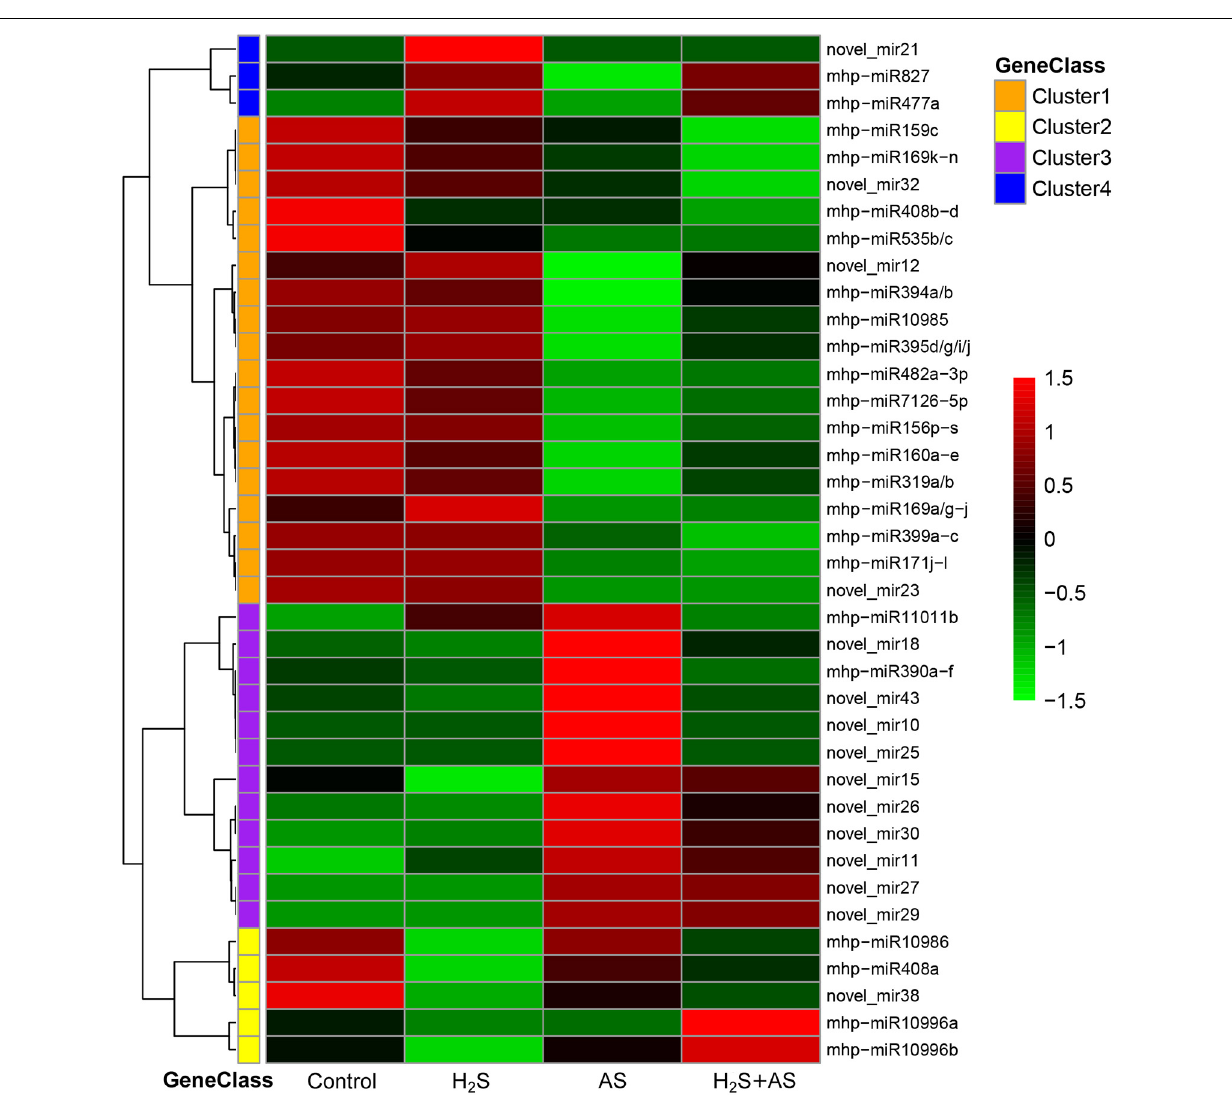
FIGURE 3 | The expression levels of differential miRNAs identified in the roots of M. hupehensis . Differentially expressed miRNAs in apple under H 2 S, H 2 S + AS, and AS stresses as compared with control treatment. These miRNAs were clustered into four classes (Cluster